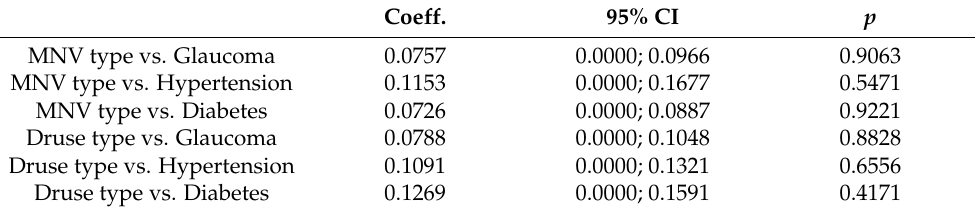
Table 4. Correlations (Phi/Cramer-V) between MNV type and druse type with systemic factors. Coeff. 95% CI